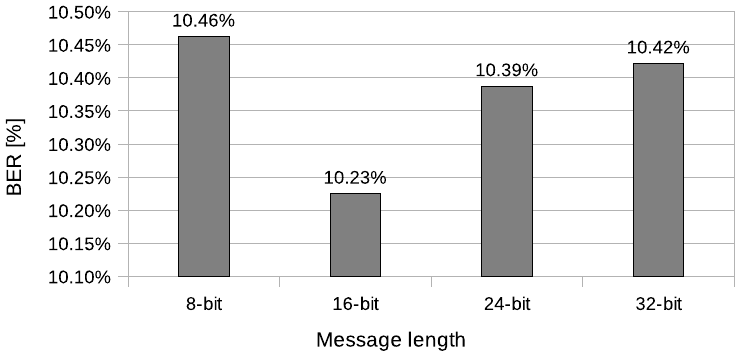
Figure 18. Measurement of the bit error rate (IEEE 802.11ac;